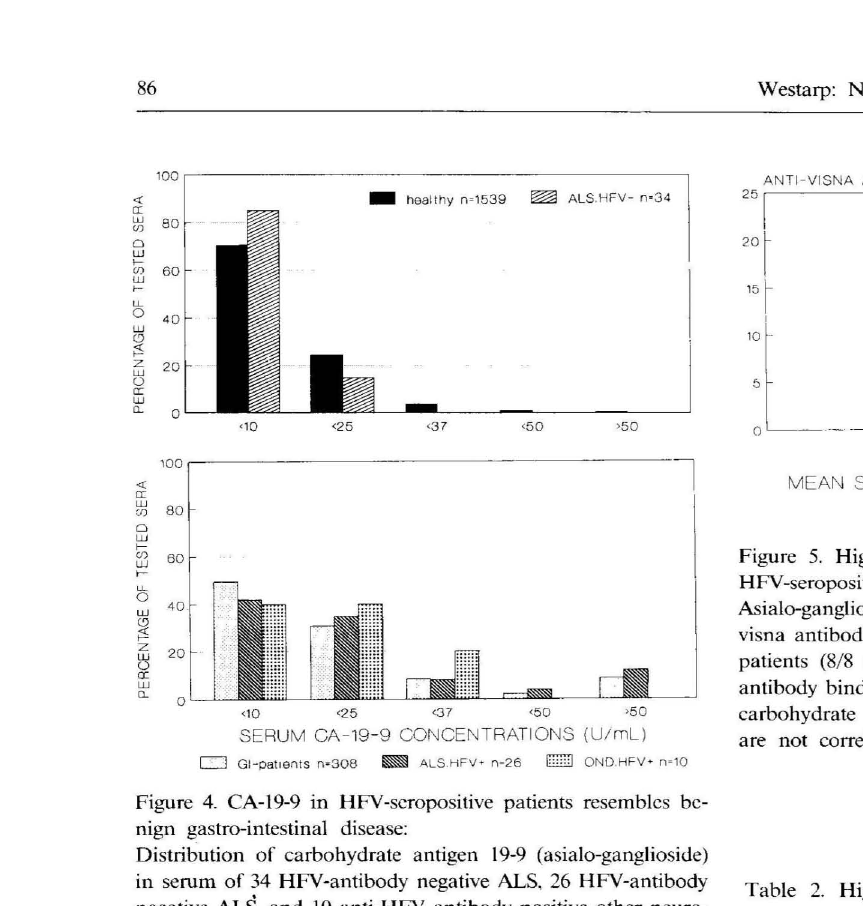
HSRV-capsid (gag) and/or envelope (env) antigens which are located on different sites of the proviral DNA Seropositivity was not confined to motor neu ron disease, yet significantly more frequent than in 195 control patients. Standardized to healthy indivi duals, ALS sera competed with secondary visna-an tibodies binding on maedi-visna-viral antigen (p<